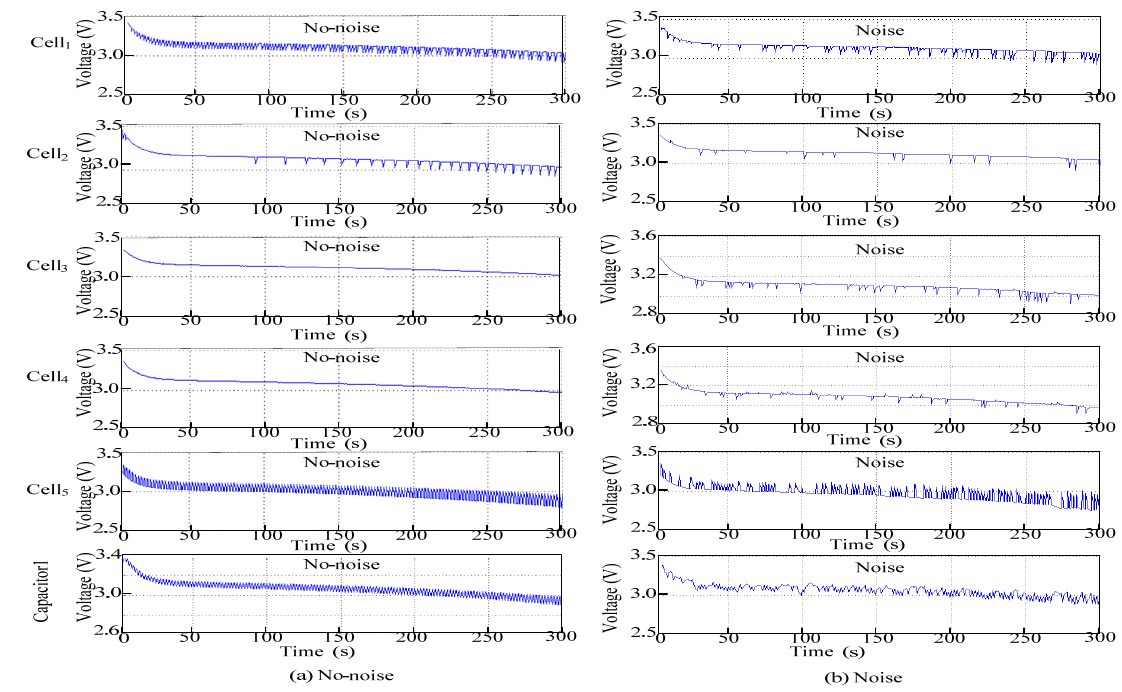
Figure 6. The voltages of Cell 1 –Cell 5 and Capacitor 1 in conditions of ( a ) no-noise and ( b )